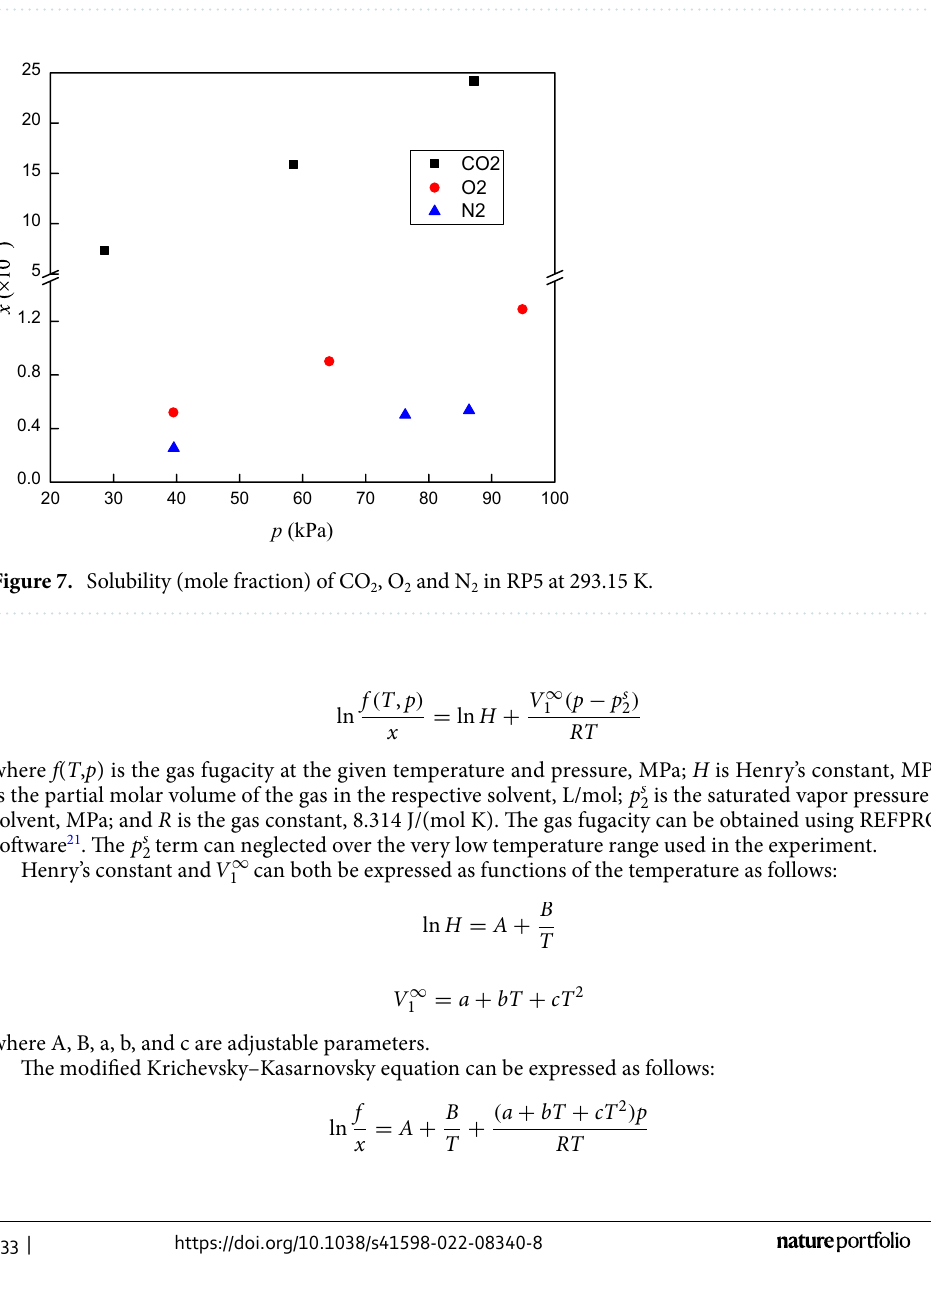
Figure 6. Solubility (mole fraction) of N 2 in RP5 versus temperature and pressure.